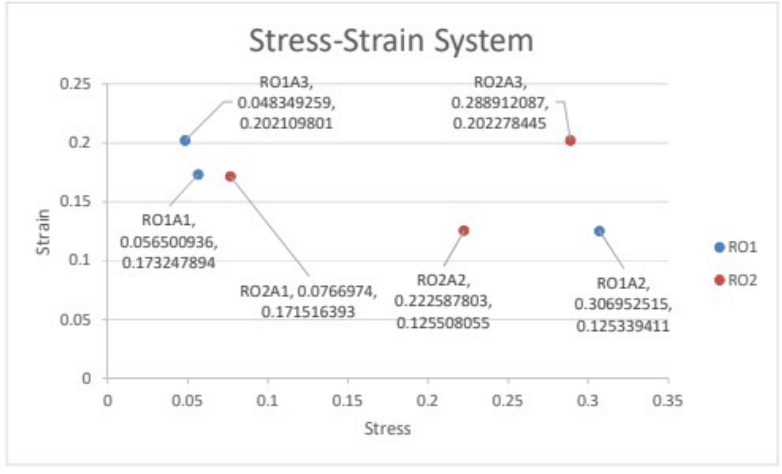
Figure 6. Strain Stress